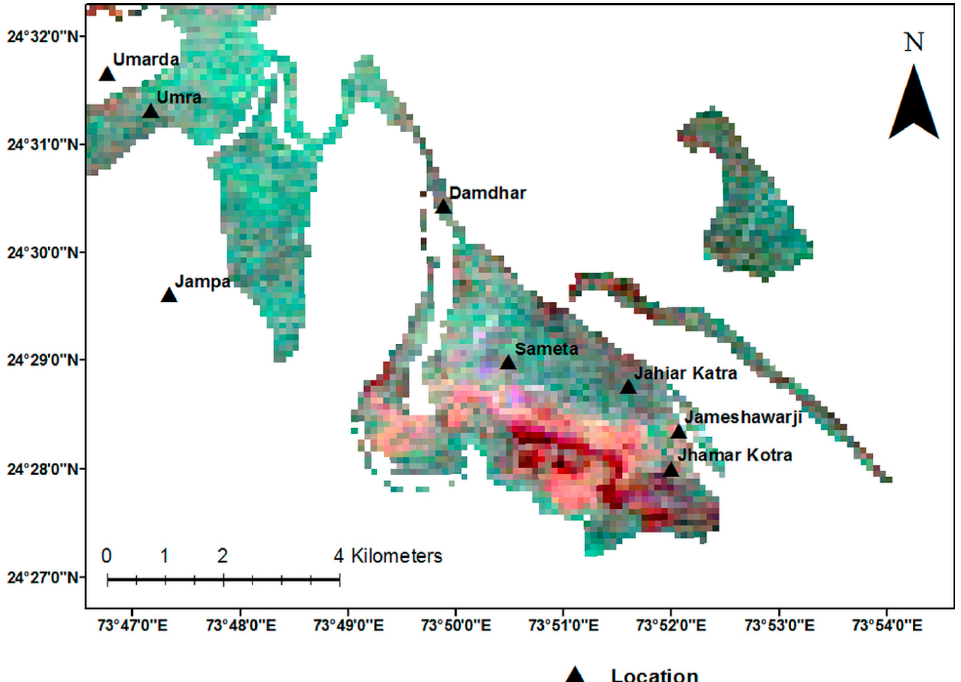
Figure 10. Decorrelation stretched false color composite prepared using spectral bands of ASTER level 1B radiance data. In this image composite, Red = Band 13, Green =band 12, and Blue = band 11 of ASTER thermal infrared sensor. Please refer to Table 1 for ASTER TIR band nuber detail.